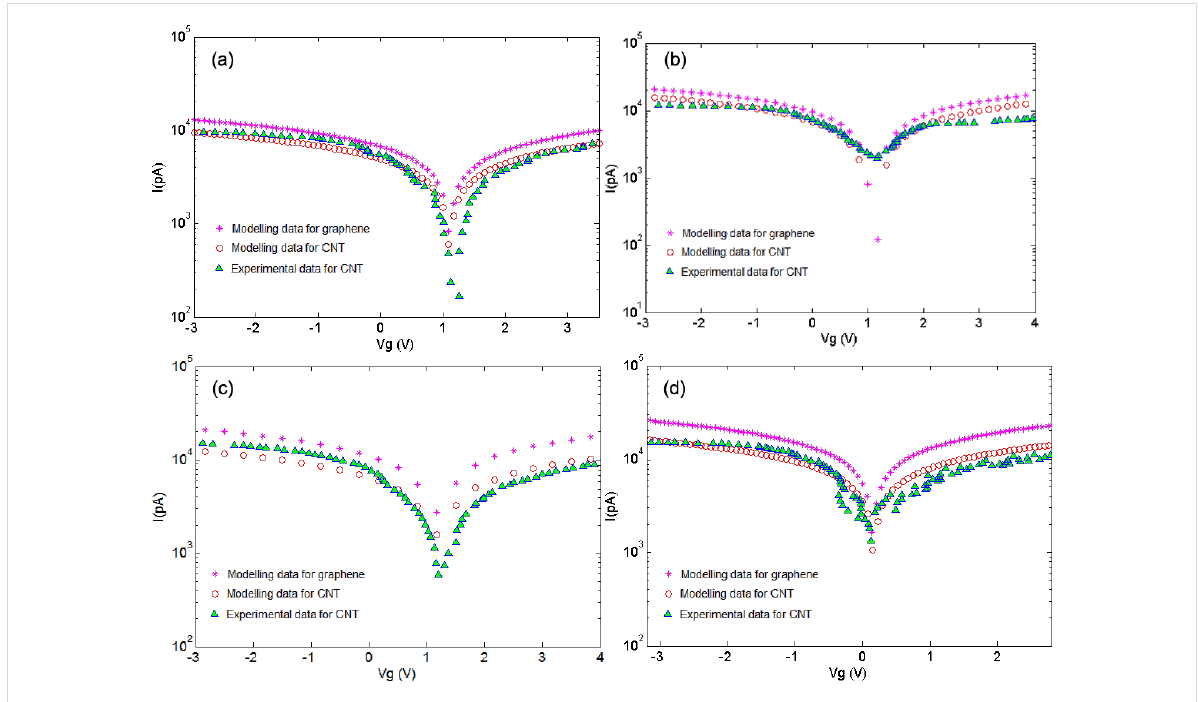
Figure 4: I – V characteristics of graphene and CNT after exposure to NH 3 under F = 500 ppm at (a) T = 25 °C, (b) T = 50 °C, (c) T = 100 °C, (d) T = 150 °C.